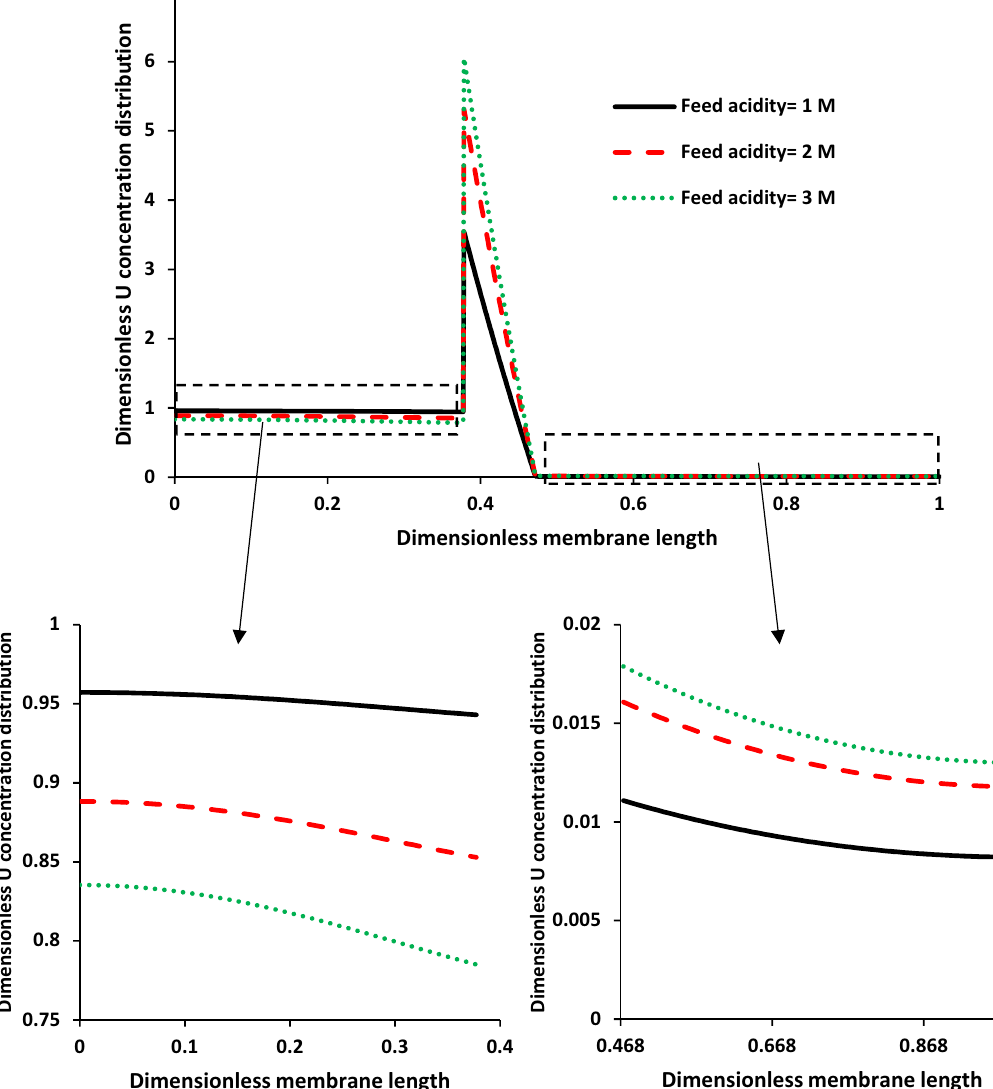
Figure 8. Dimensionless uranium concentration distribution in radial direction at different feed